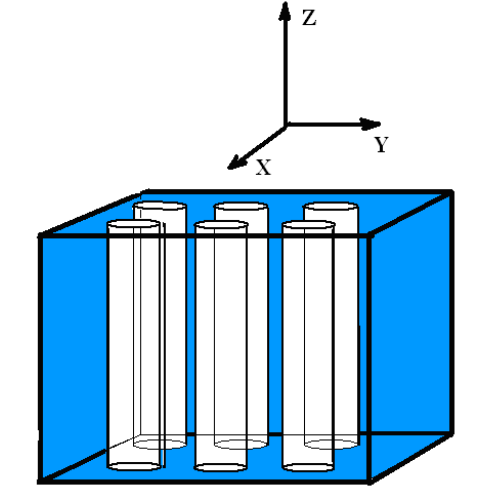
Figure 1: Metamaterial made of metallic nanocylinders periodically embedded in the dielectric template